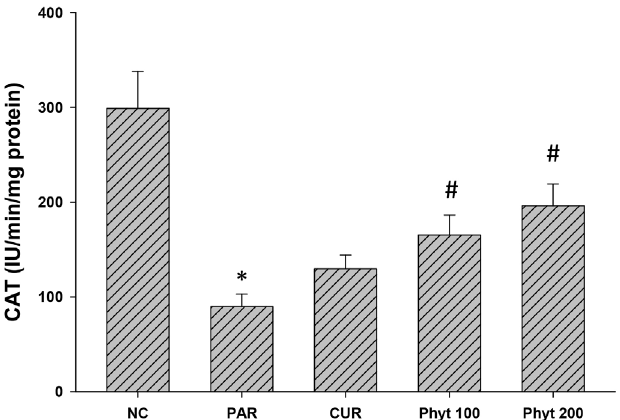
FIGURE 9 - Effect of phytosome curcumin on CAT activity of control and treated animals in paracetamol-induced liver injury in mice. Value represents as mean ± S.D. * p<0.05, significant difference compared with control group, # p<0.05, significant difference compared with paracetamol group ( n = 10).